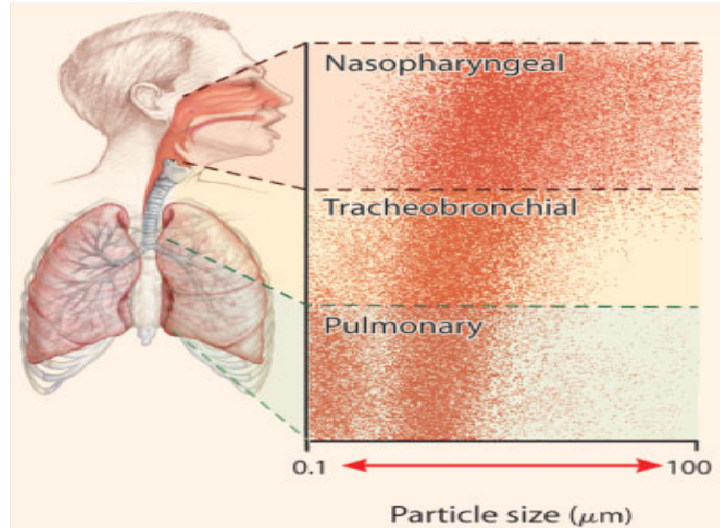
Figure 4. A schematic diagram dividing the respiratory system into three regions (nasopharyngeal region, tracheobronchial region, and pulmonary region) with possible penetrated particle sizes. Authorized copy from [71].